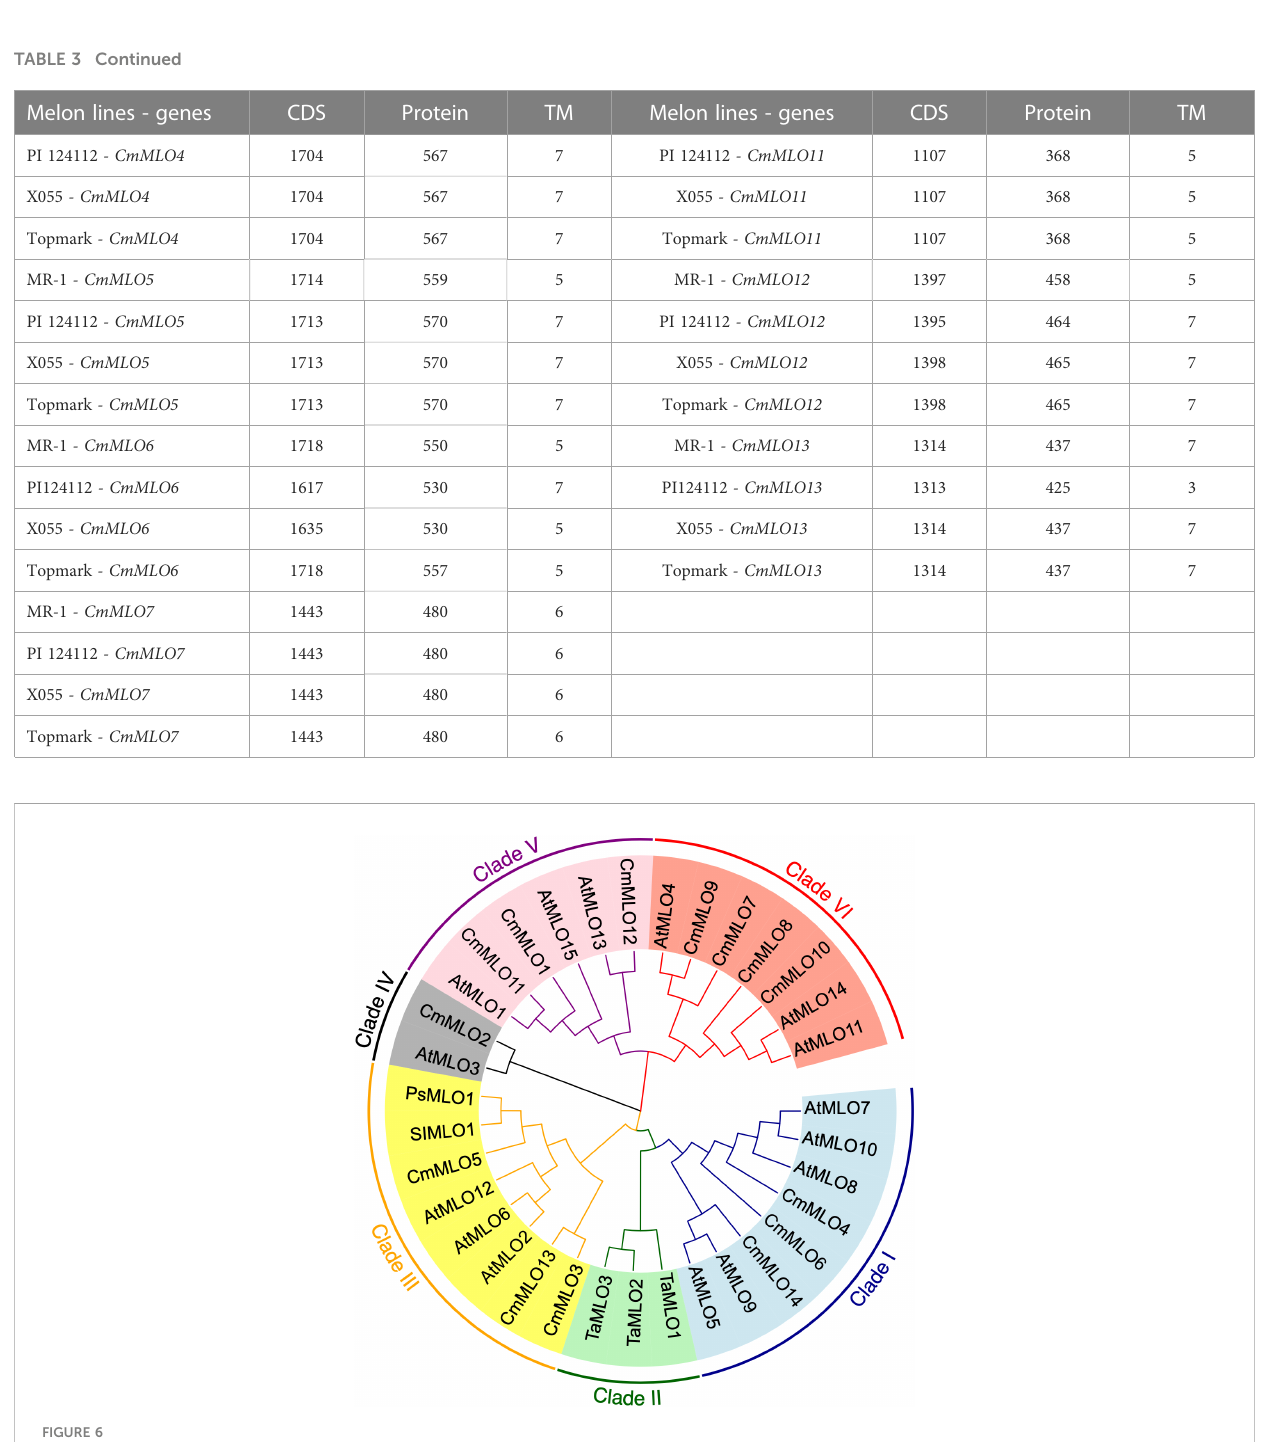
FIGURE 6 Schematic diagram of the CmMLO gene family in constructed phylogenetic